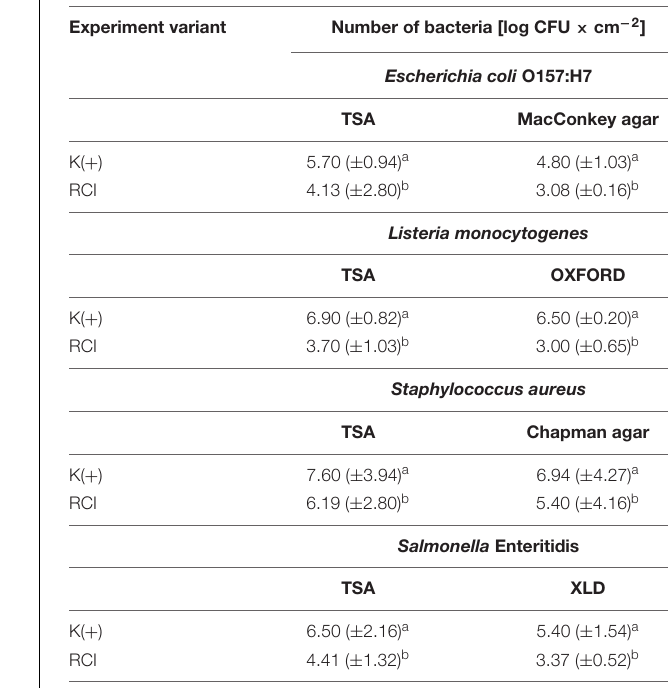
TABLE 1 | The number of bacteria re-isolated from a steel surface and cultivated on various